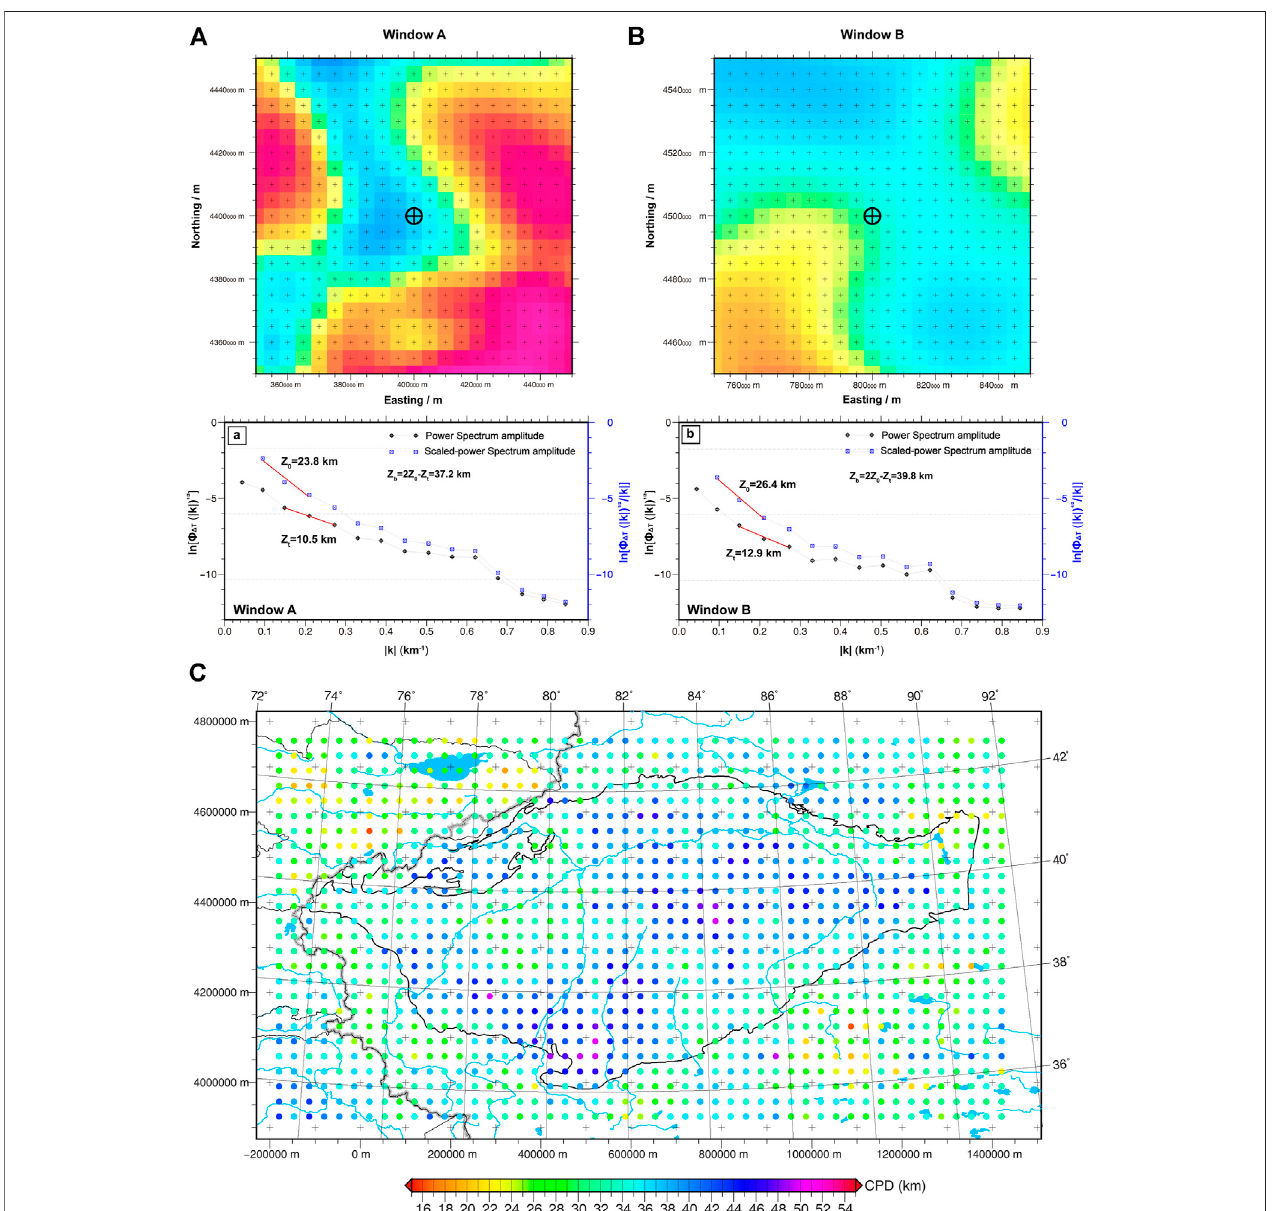
FIGURE 3 | Examples of power spectrum amplitude for estimations of Curie depth using the 2D upward-continued magnetic anomaly data, covering the 100 × 100 kmCurie-Z b calculationwindows (A,B) centeredon400000 m/4400000 mand800000 m/4500000 m,markedbyblackcrosseswithboundedblackcircles, respectively. The black crosses locate the center ofeach grid bin within 5 × 5 km (Panel A,B). According toTanaka et al.(1999), Z 0 , Z t and Z b are de fi ned as the centroid, thetopandbottomdepthsforaselectedgridwithasizeof100 × 100 km(windowsA,B),respectively.| k |isthewavenumber, and V △ T (| k |) 1/2 and[ V △ T (| k |) 1/2 ]/| k |are theamplitudespectrumandscaledamplitudespectrumofthemagneticanomaly,respectively(Panela,b).Thecorrectedmagneticanomalymapofthewholestudyarea has been subdivided into 1,274 estimated windows with a size of 100 × 100 km and a shift between windows of 33.33 km (C) .